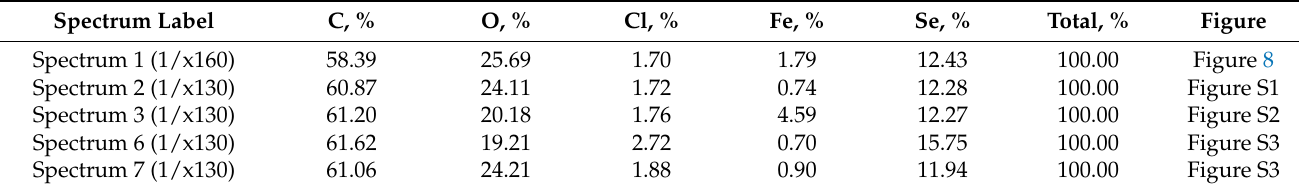
Table 2. The content of elements (%) present on the A-LMS Fe 3 O 4 /Se surface. Spectrum Label Spectrum 1 (1/x160) Spectrum 2 (1/x130) Spectrum 3 (1/x130) Spectrum 6 (1/x130) Spectrum 7 (1/x130)